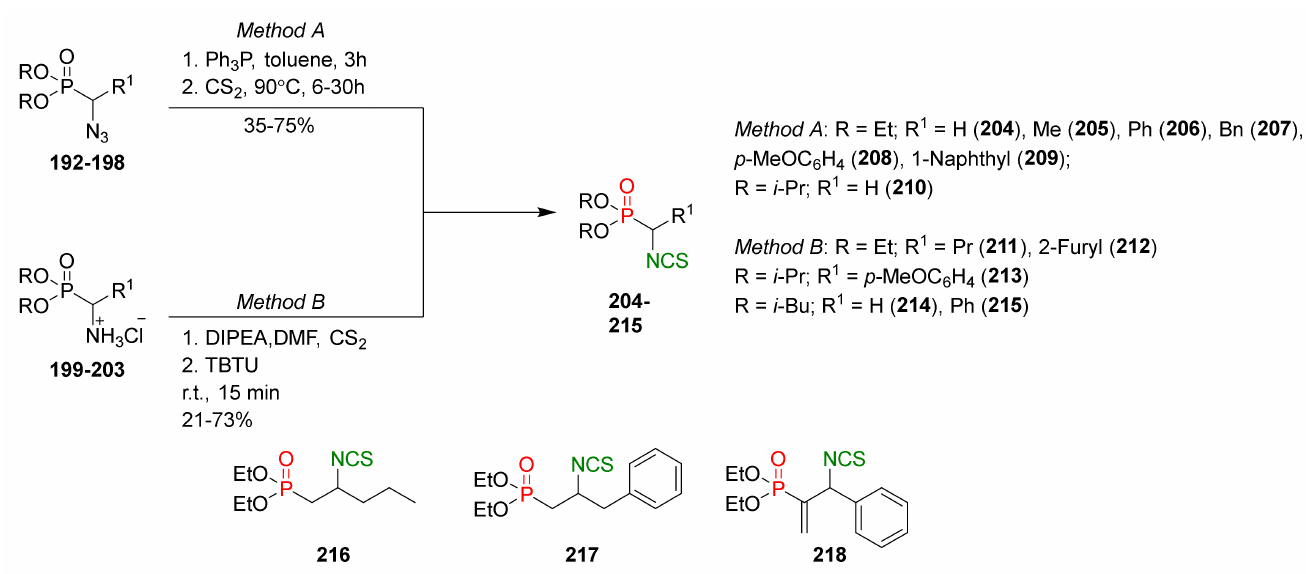
Figure 34. Synthesis of α - and β -dialkoxyphosphoryl isothiocyanates 204 – 218 .